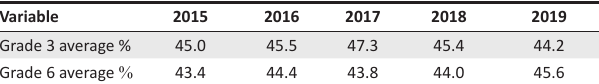
TABLE 1: Western Cape Education Department English language provincial results from 2015 to 2019, indicating the percentages of learners who passed.